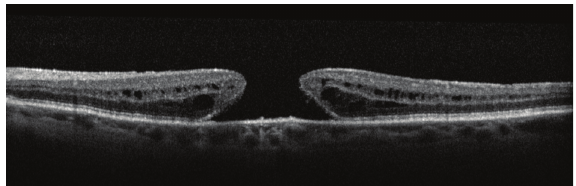
Figure 6: Full thickness macular